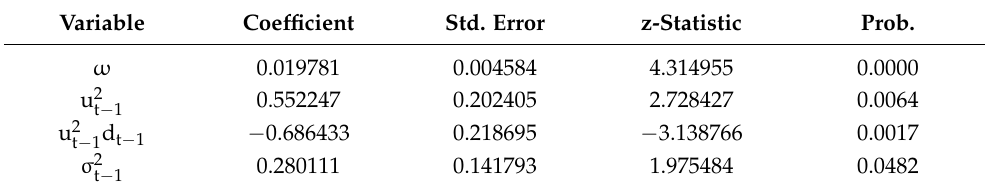
Table 6. The TARCH estimation result of oil price volatility from supply shock and VIX index.